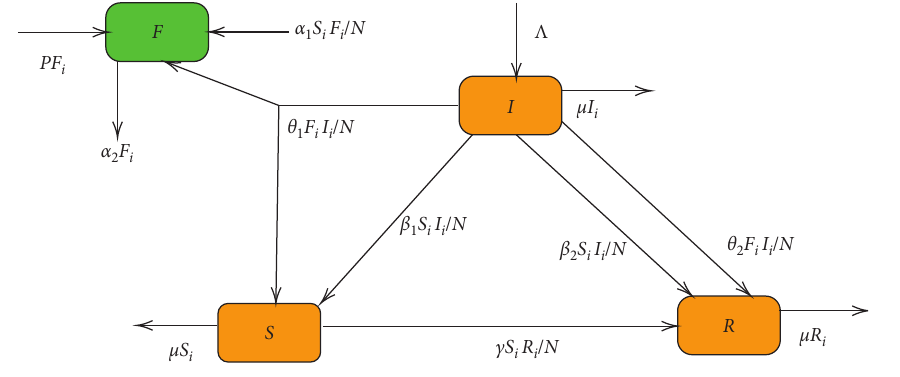
Figure 1: Flow chart for the models (1)–(4). Table 1: Parameters